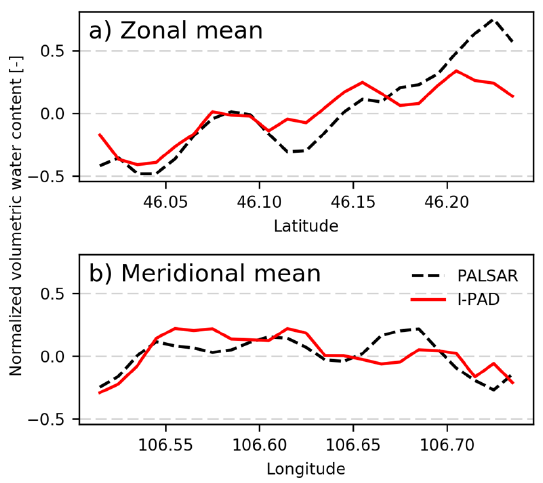
Figure 5. Spatial distributions of normalized surface soil moisture on ( a ) 21 July 2009 obtained by PALSAR, and on 5 September 2009 obtained by ( b ) PALSAR and ( c ) I-PAD.